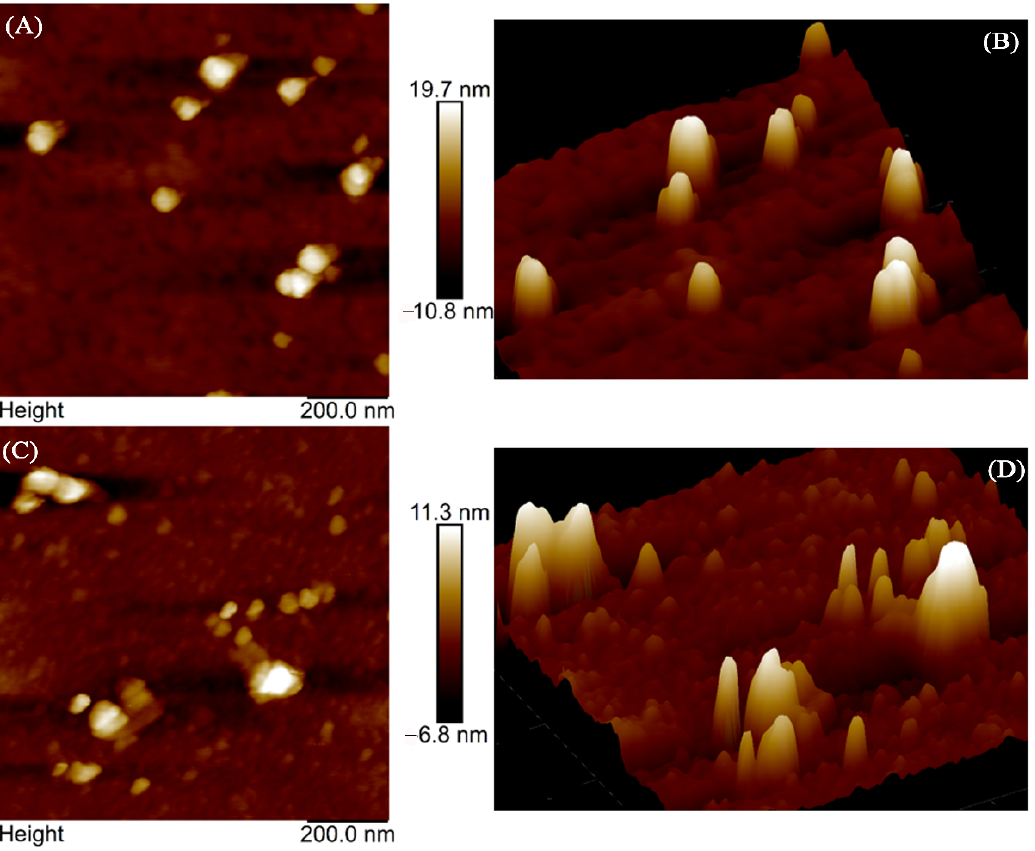
Figure 10. The 2D ( A , C ) and 3D ( B , D ) AFM images of HSA (3 μ M) in the absence and presence of GDC-0941 (9 μ M).